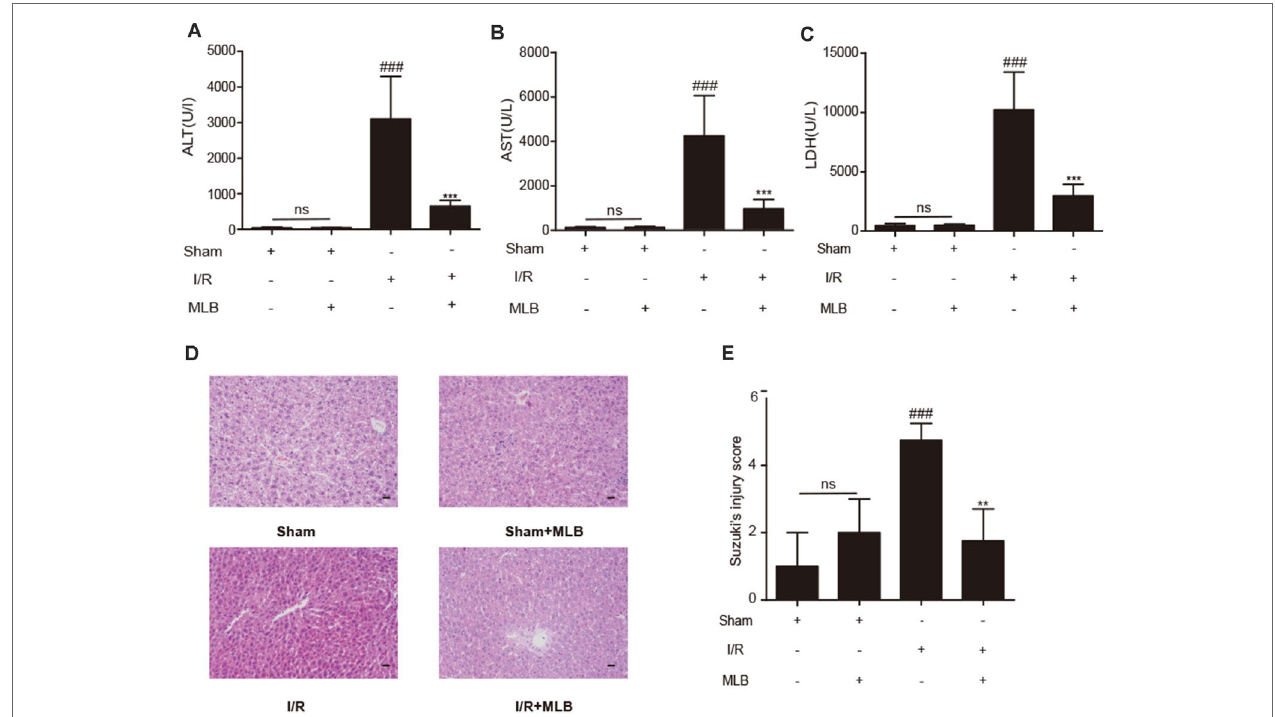
FIGURE 2 | MLB pretreatment attenuates liver injury caused by ischemia–reperfusion. (A–C) The levels of ALT, AST, and LDH in sham, I/R, and MLB pretreatment groups. (D , E) Classical images of sham, I/R, and MLB treatment groups were examined by H&E staining, and histopathological score was calculated by Suzuki’s scoring standard, magnification x200, scale bar 50 μ m. Data shown are mean ± SD; ns: no statistical significance; ### P < 0.001 versus sham group; **P < 0.01, and ***P < 0.001 versus I/R group; n = 5 for each